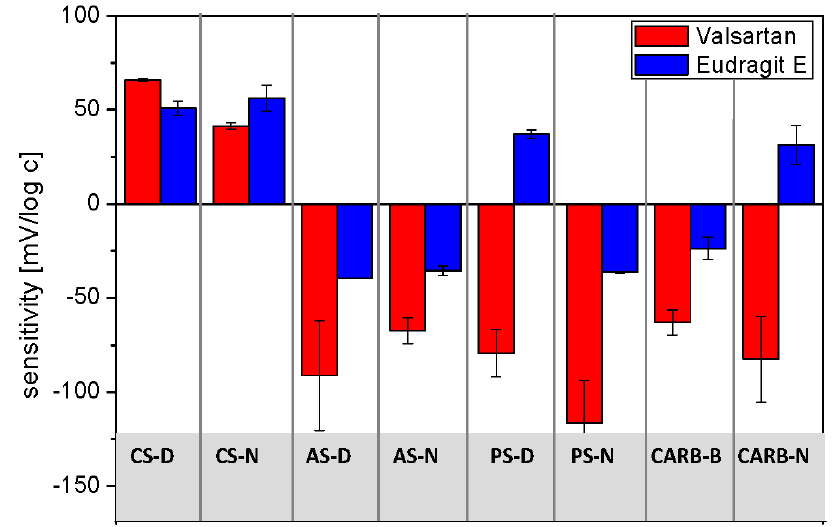
Figure 3. Sensitivity of sensors towards Valsartan and Eudragit E (mean ± SD; n = 3).